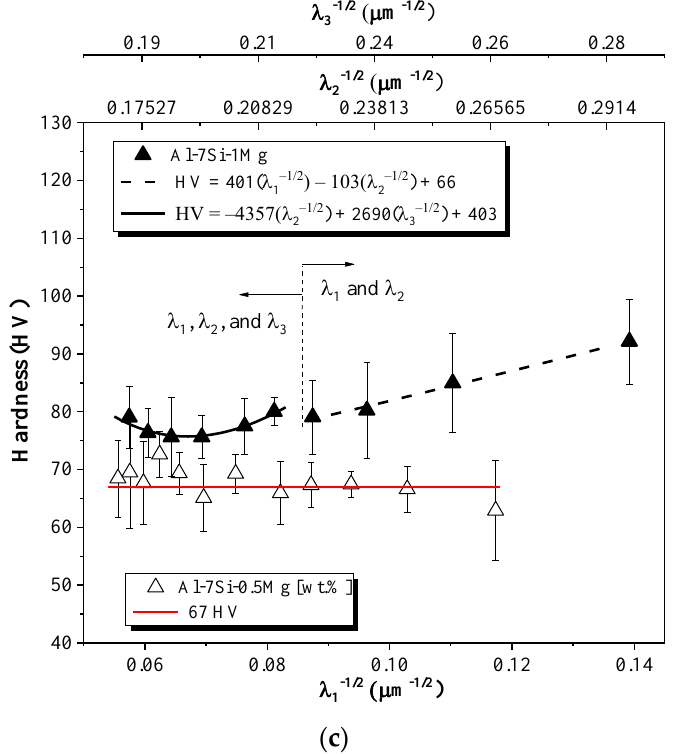
Figure 11. MLR plots for both Al-7Si-0.5Mg and Al-7Si-1Mg alloys: ( a ) ultimate tensile strength ( b ) elongation and ( c ) hardness.